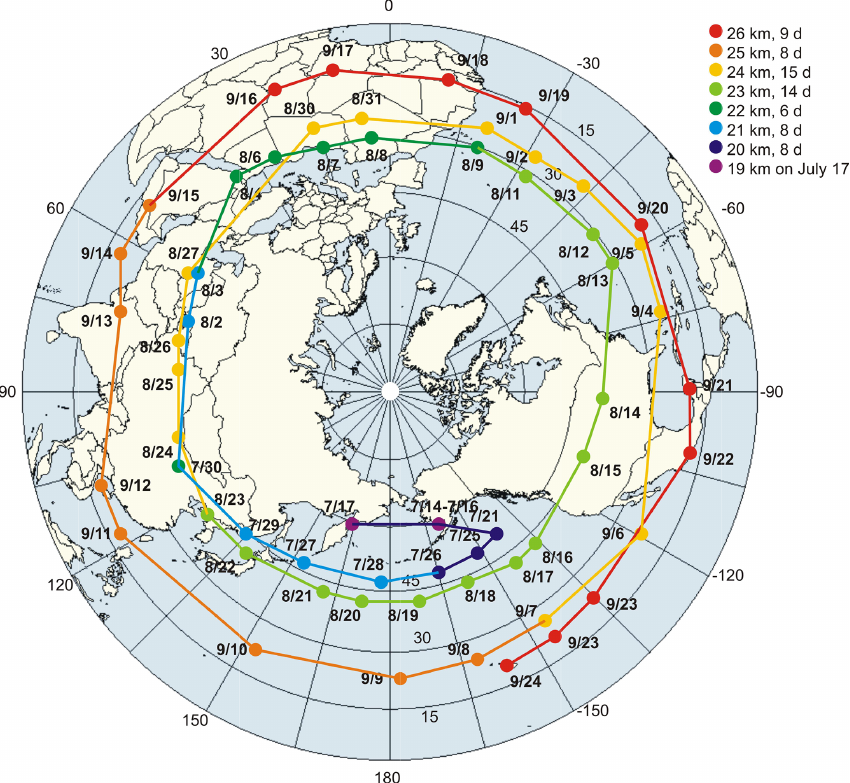
Figure 6. Back trajectory of the Raikoke plume between 24 September and 17 July 2019 derived from CALIOP L1 attenuated backscatter